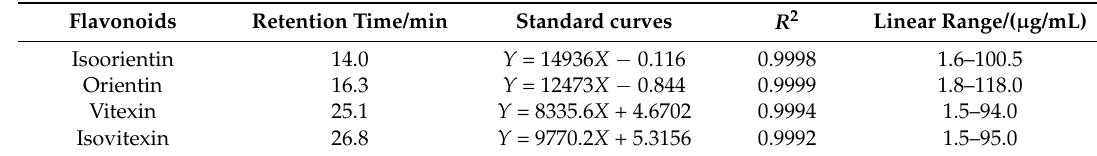
Table 3. Standard curves and linear ranges of detection of bamboo